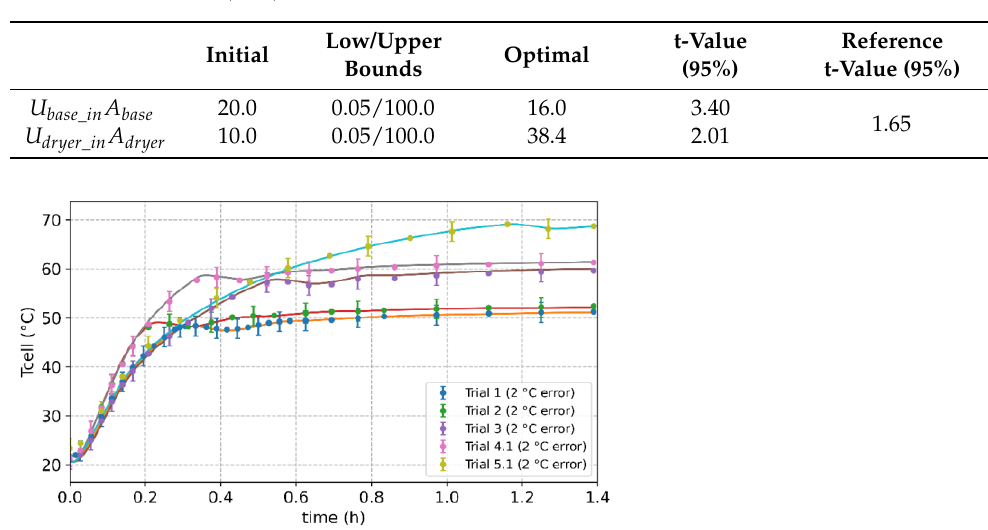
Table 3. Initial guesses, lower and up bounds, optimal values of the model parameters, t-value (95%) and reference t-value (95%).